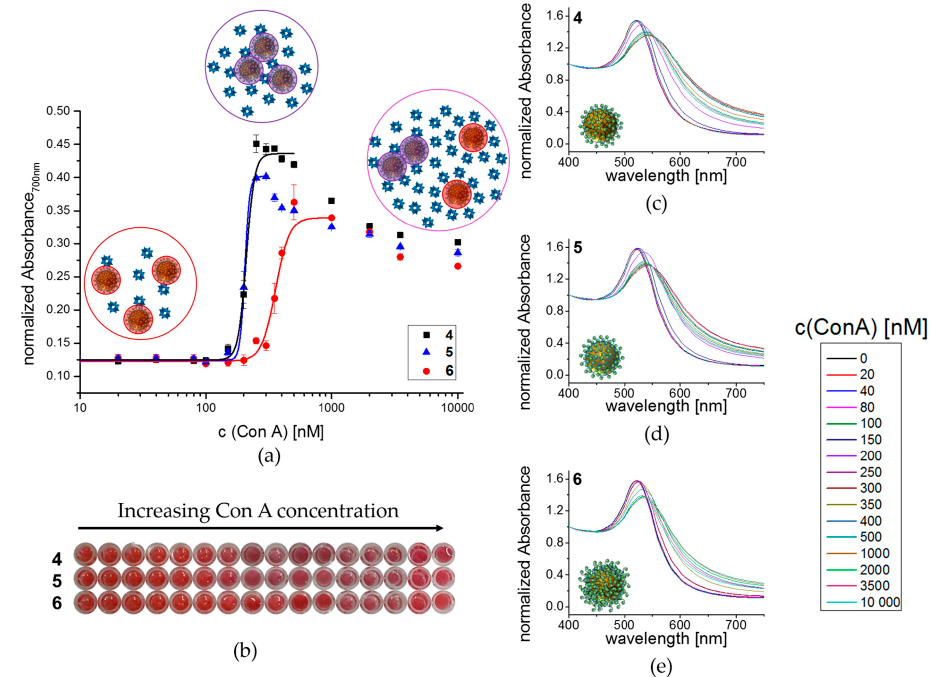
Figure 3. Aggregation behavior of glyco-AuNPs when exposed to different concentrations of Con A: ( a ) The normalized absorbance (normalized to absorbance at 400 nm) at 700 nm is plotted in dependence of Con A concentration, the different situations in solution are presented schematically; ( b ) Photograph of 96-well plate (background removed); ( c ) UV-Vis absorbance spectra for 4 ; (d) 5 ; ( e ) 6 in dependence of Con A concentration. Table 2. Apparent dissociation constant K D,app in nM for glyco-AuNPs 4 – 6 and derived K D,app values corrected for glycomacromolecule and carbohydrate number per nanoparticle in µM. Glyco-Au-NP K D,app [nM]